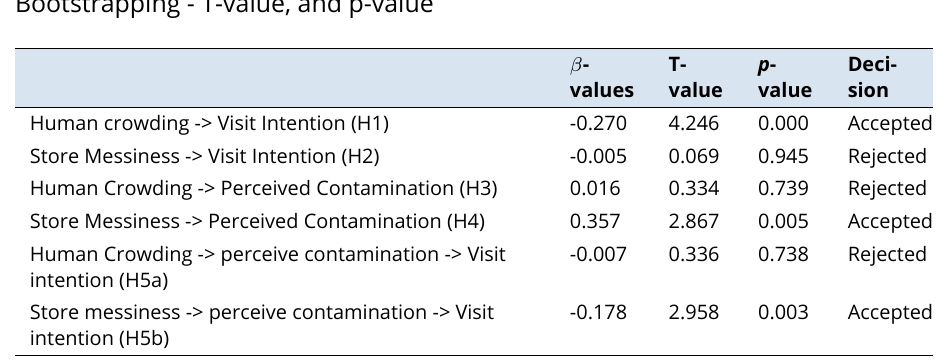
Bootstrapping - T-value, and